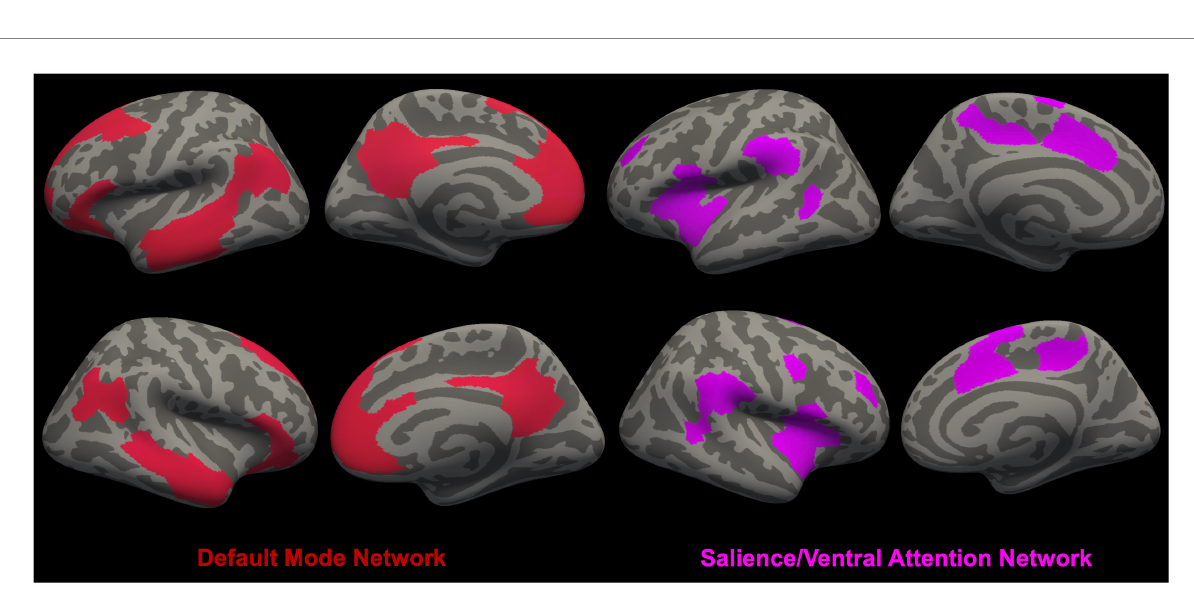
Fan et al. also found lower FA in the dorsal and ventral frontal regions that included the uncinate fasciculus for individuals with MDD and a history of suicide attempts as compared to non-suicide attempters (60).